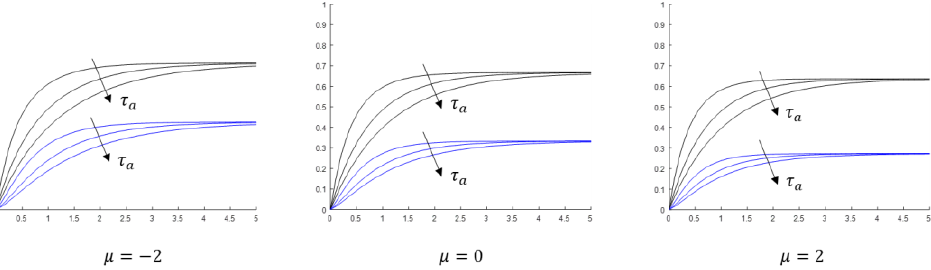
Figure 4. The temperature in the tank 𝜓 (black) and on the contact surface of liquid–solid-body 𝜃| 𝜉=0 (blue) as a function of the time 𝜏 for 𝜏 𝑎 = 𝜏 𝑐 = 0.5 , 𝜏 𝑎 = 𝜏 𝑐 = 1 , and 𝜏 𝑎 = 𝜏 𝑐 = 1.5 (the three curves in each bundle). The thermal conductivity is 𝑔(𝜃) = 𝑒 𝜇𝜃 ,𝜇 = −2, 0, 2 .